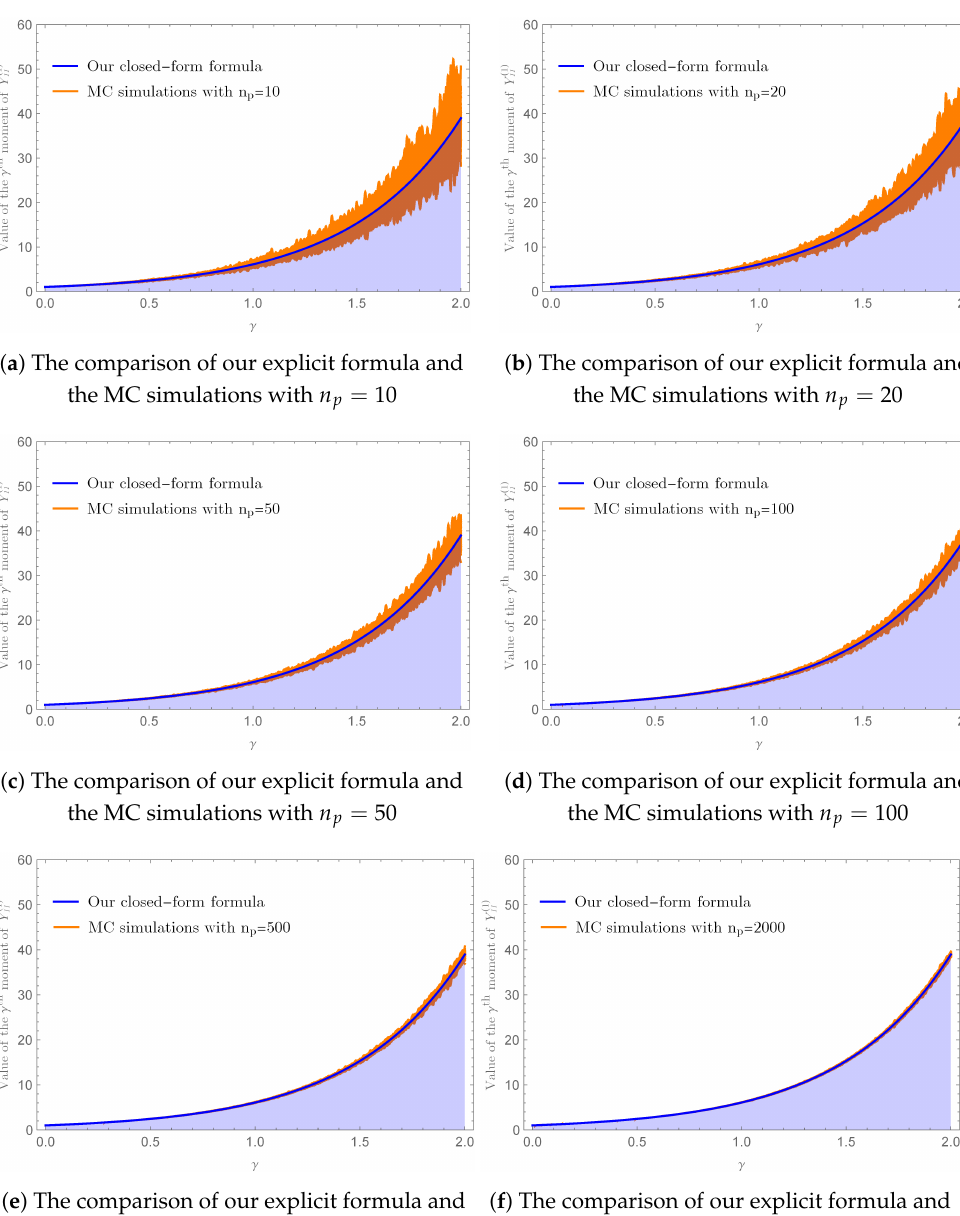
Figure 5. The variation on the approximate values of E in Example 2 with an increasing number of sample paths, demonstrating the convergence of the approximate values obtained from MC simulations to the one computed by using our Formula (8) with K = K 1 = 100 terms in the infinite series, when the number of sample paths approaches